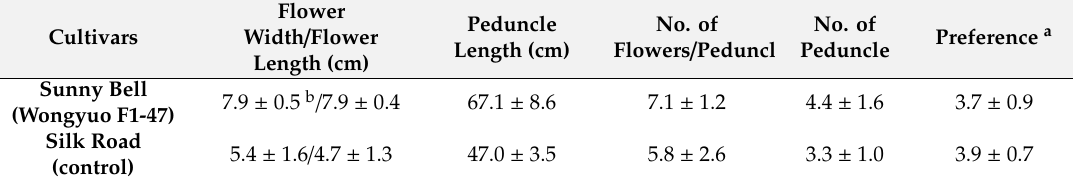
Table 2. Comparative characteristics of flowers of a new hybrid, Cymbidium “Sunny Bell”.